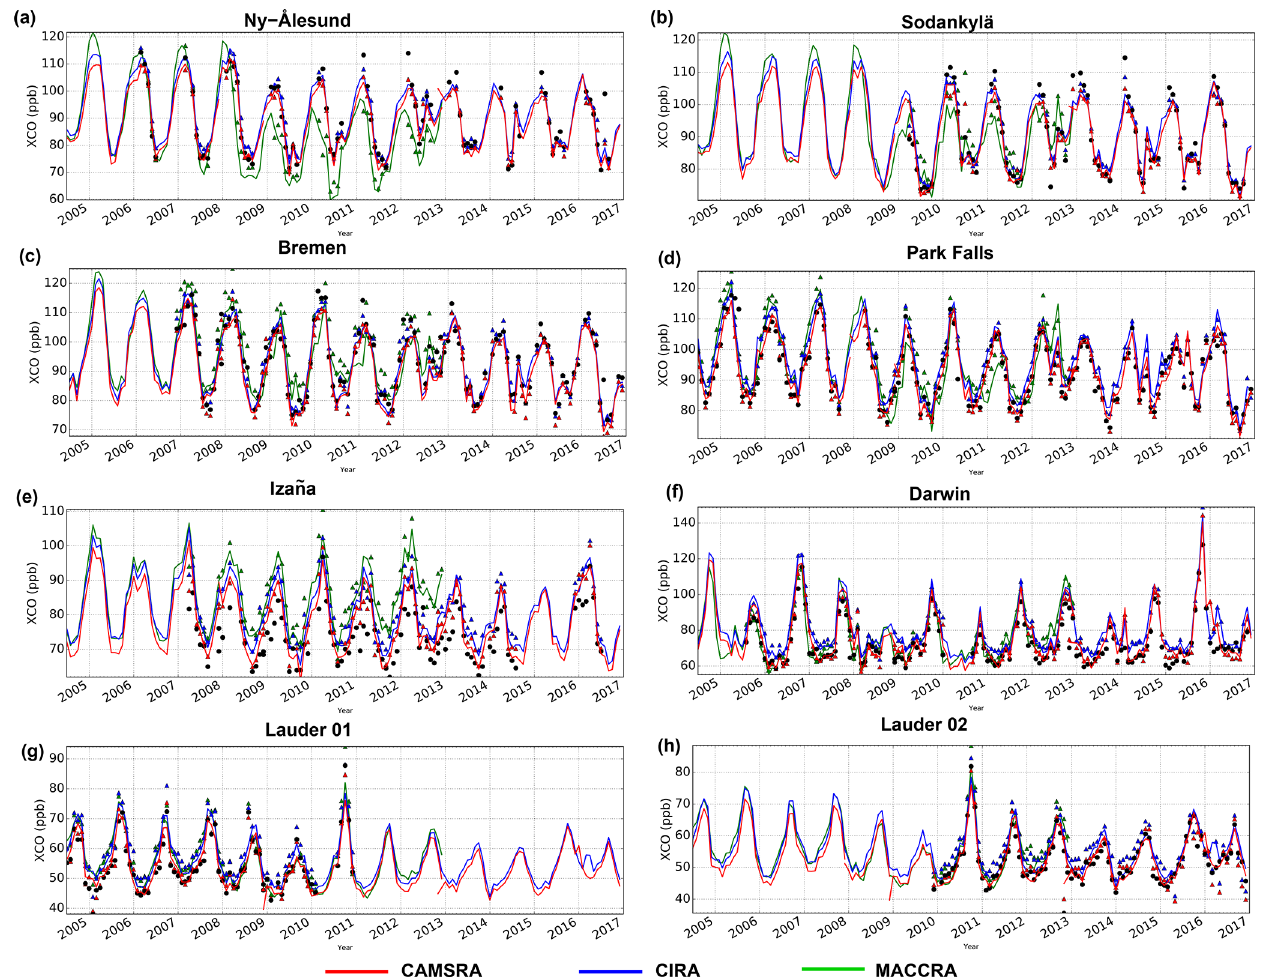
Figure 13. Column-averaged CO (XCO; in ppb) at several TCCON stations. Monthly mean observations are shown by the black dots, and corresponding monthly mean XCO columns calculated using the TCCON averaging kernels are shown by the red (CAMSRA), blue (CIRA) and green (MACCRA) triangles. The continuous lines are the monthly XCO for the three reanalyses. Shown are data for (a) Ny-Ålesund,